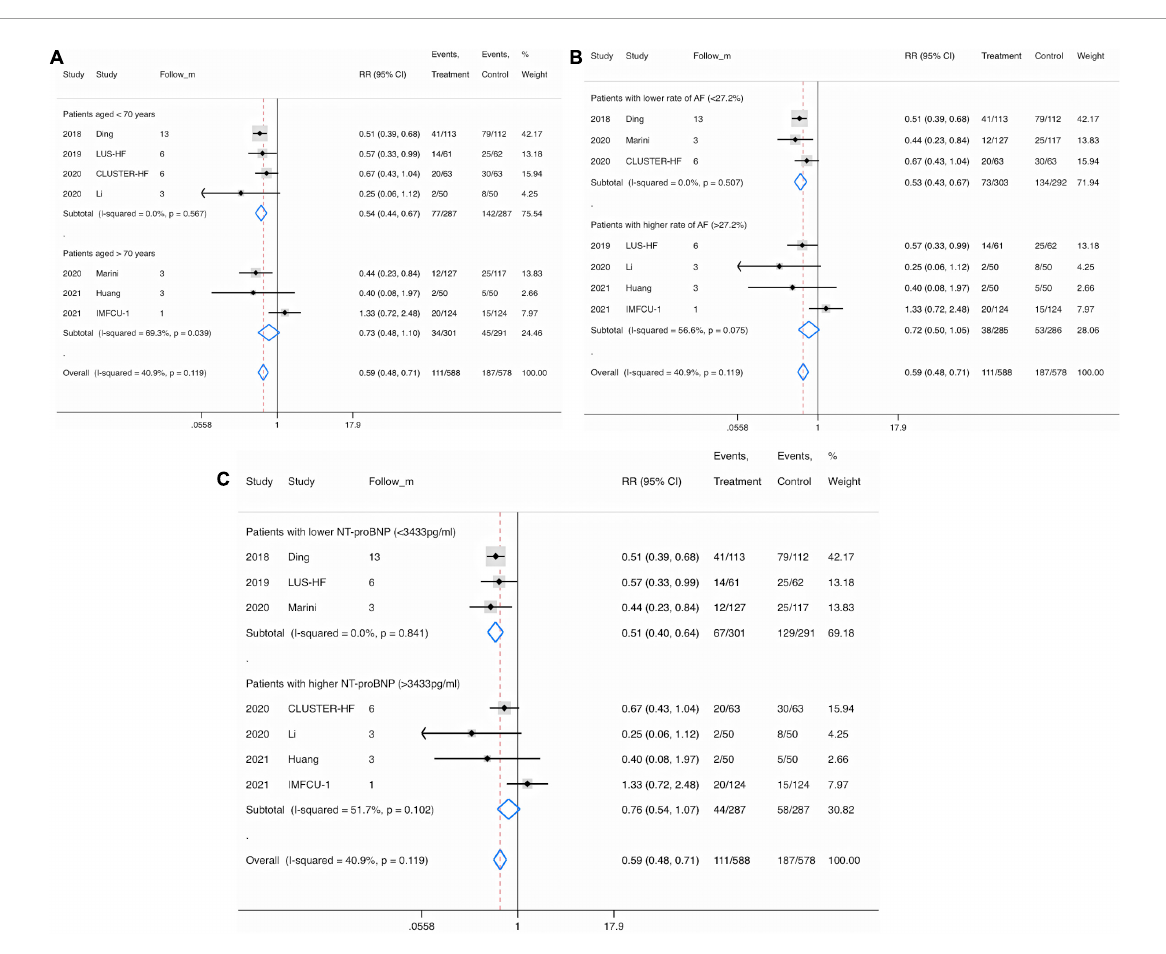
FIGURE7 Subgroup analysis for major adverse cardiac event in patients specified by age (A) , atrial fibrillation (B) , and N-terminal pro-B-type natriuretic peptide concentration (C) . Fixed-effects model ( I 2 = 40.9%). LUS, lung ultrasound; MACE, major adverse cardiac event; RR, relative risk; CI, confidence